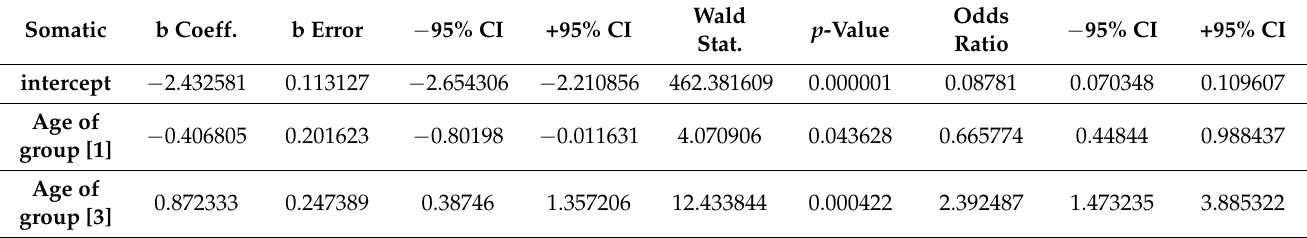
Table 10. Logistic regression model for somatic symptoms of fear and three age groups.